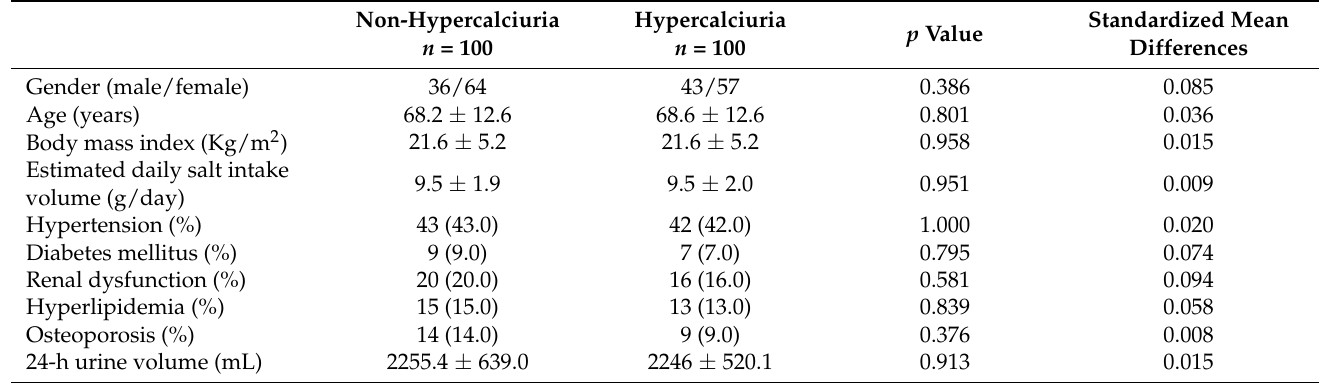
Table 5. Baseline characteristic data of hypercalciuria after propensity score matching.